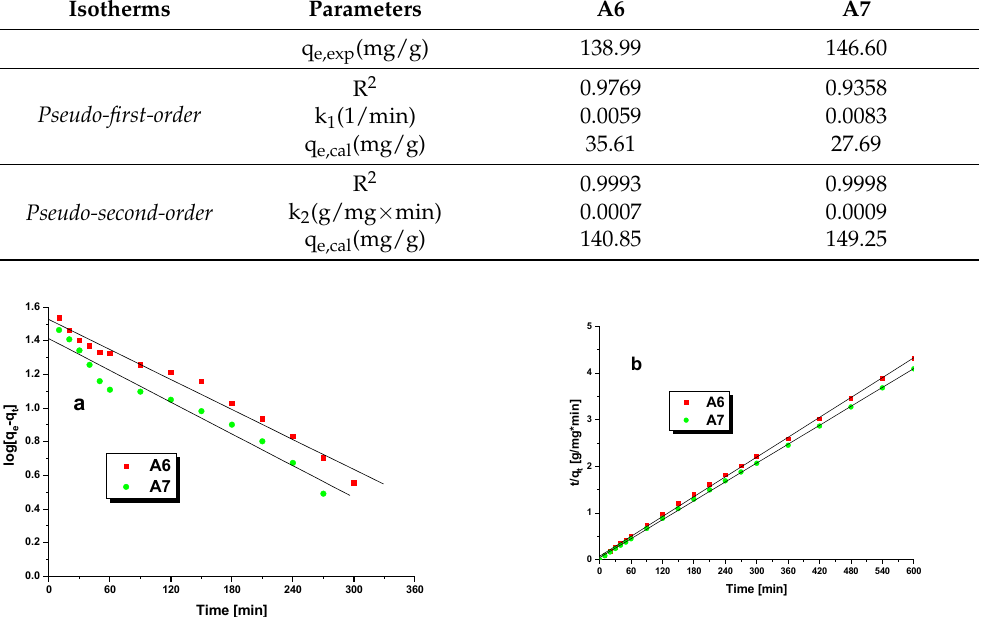
Table 7. Kinetic parameters for the adsorption of methylene blue.